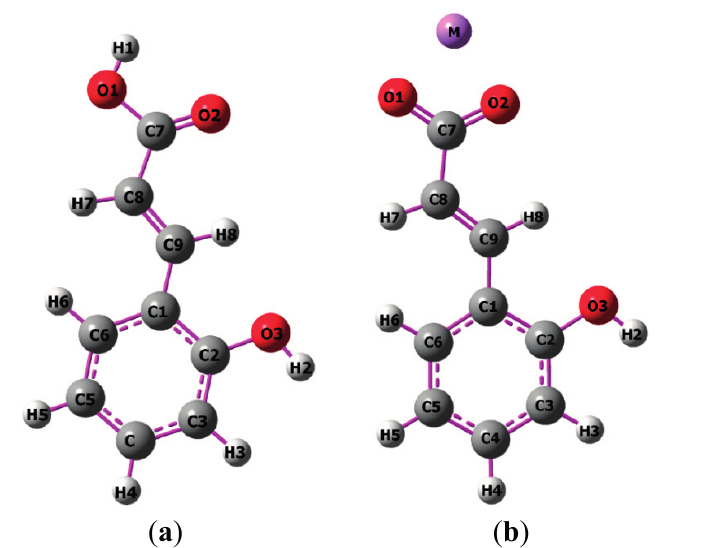
Figure 1. Structures of: trans o -coumaric acid ( a ) and alkali metal o -coumarates (M = Li, Na, K, Rb, Cs) ( b